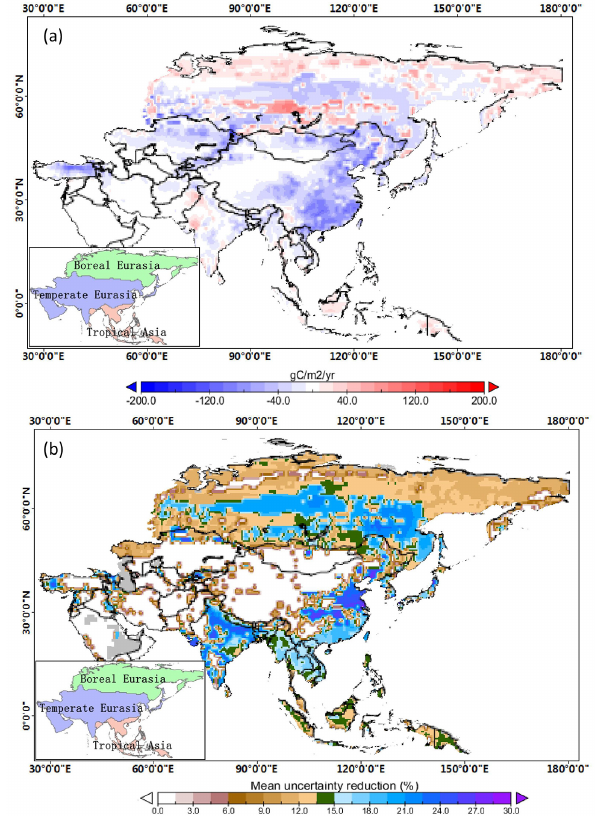
Figure 8. (a) The inverted flux difference between surface CO 2 observation data only surface (surface-only) and both the surface CO 2 observation data and CONTRAIL data (surface-CONTRAIL); and (b) the Gaussian error reduction rate between surface-only and surface-CONTRAIL during the period 2006–2010. The flux differ- ence is derived from (surface-CONTRAIL – surface-only), while the Gaussian error reduction rate is calculated as (σ surface − only − σ surface − CONTRAIL )/σ surface − only ×